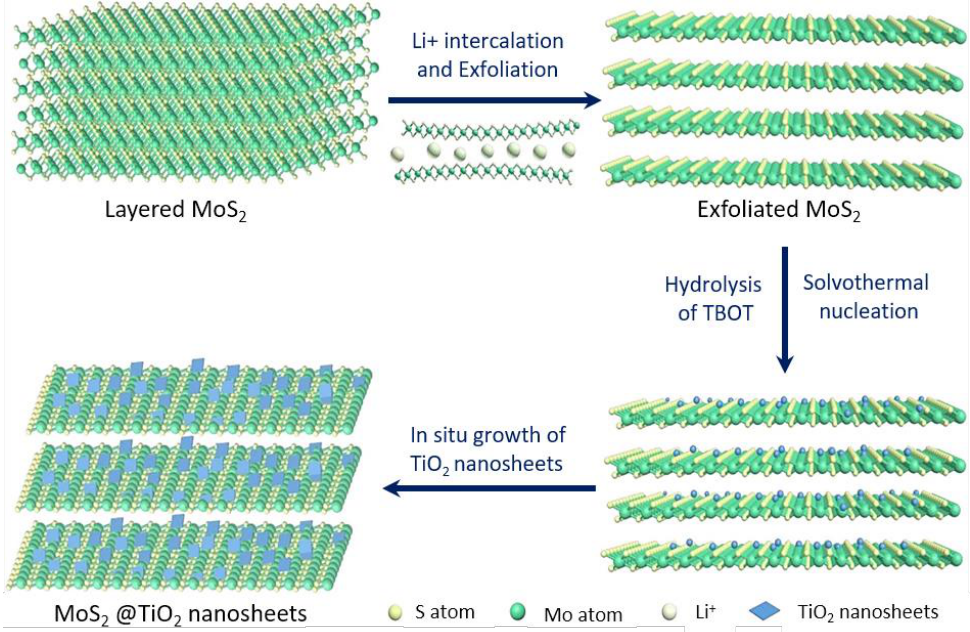
Figure 33. Schematic of the synthesis of hierarchical MoS 2 @TiO 2 nanosheets. Reprinted with permission from Ref. [232]. Copyright 2019, Elsevier.